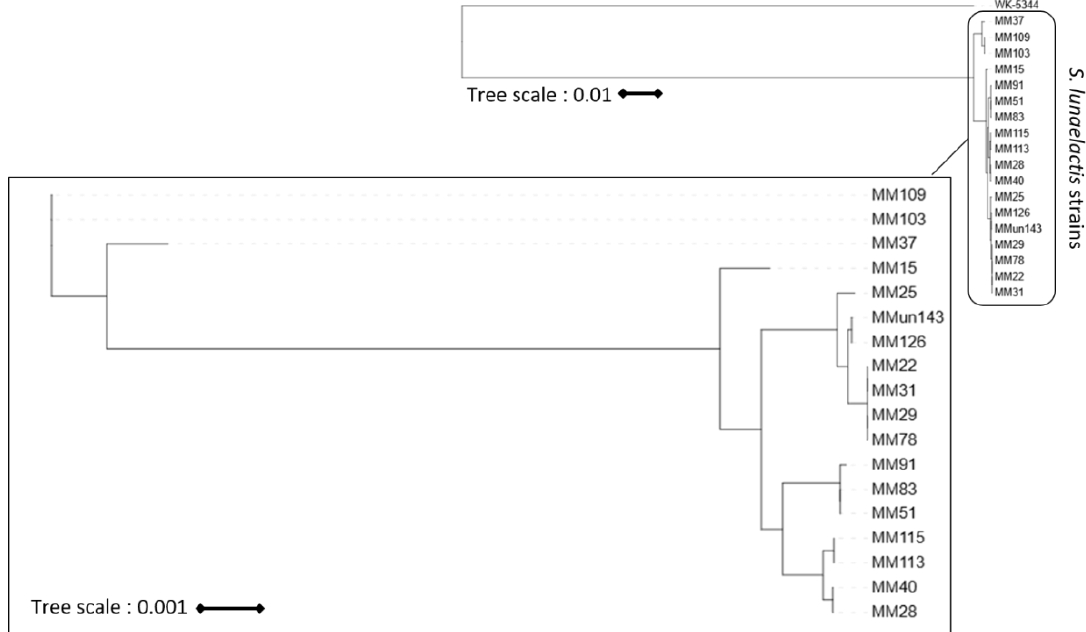
Figure 3. Phylogeny analysis of 18 S. lunaelactis strains based on the fev / bag BGC. The first tree (top right) is rooted on the sequence of the bag / fev cluster of Streptomyces sp. WK-5344 (AB689797.1). The scale bar indicates 1% of estimated sequence divergence. The second tree only includes the 18 S. lunaelactis strains to optimally visualize strain clustering. The scale bar indicates 0.1% of estimated sequence divergence.